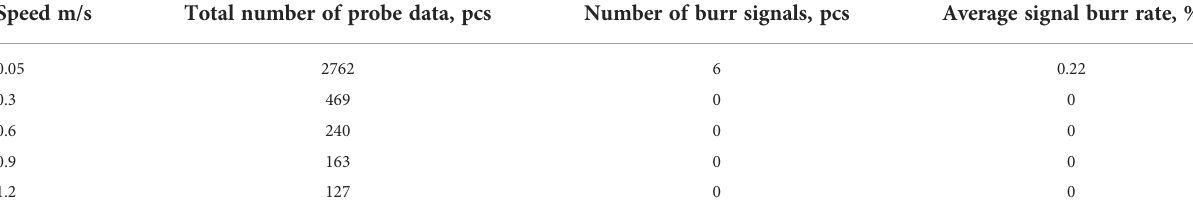
TABLE 4 Signal glitch rate of ultrasonic sensors for detecting regular step. Speed m/s